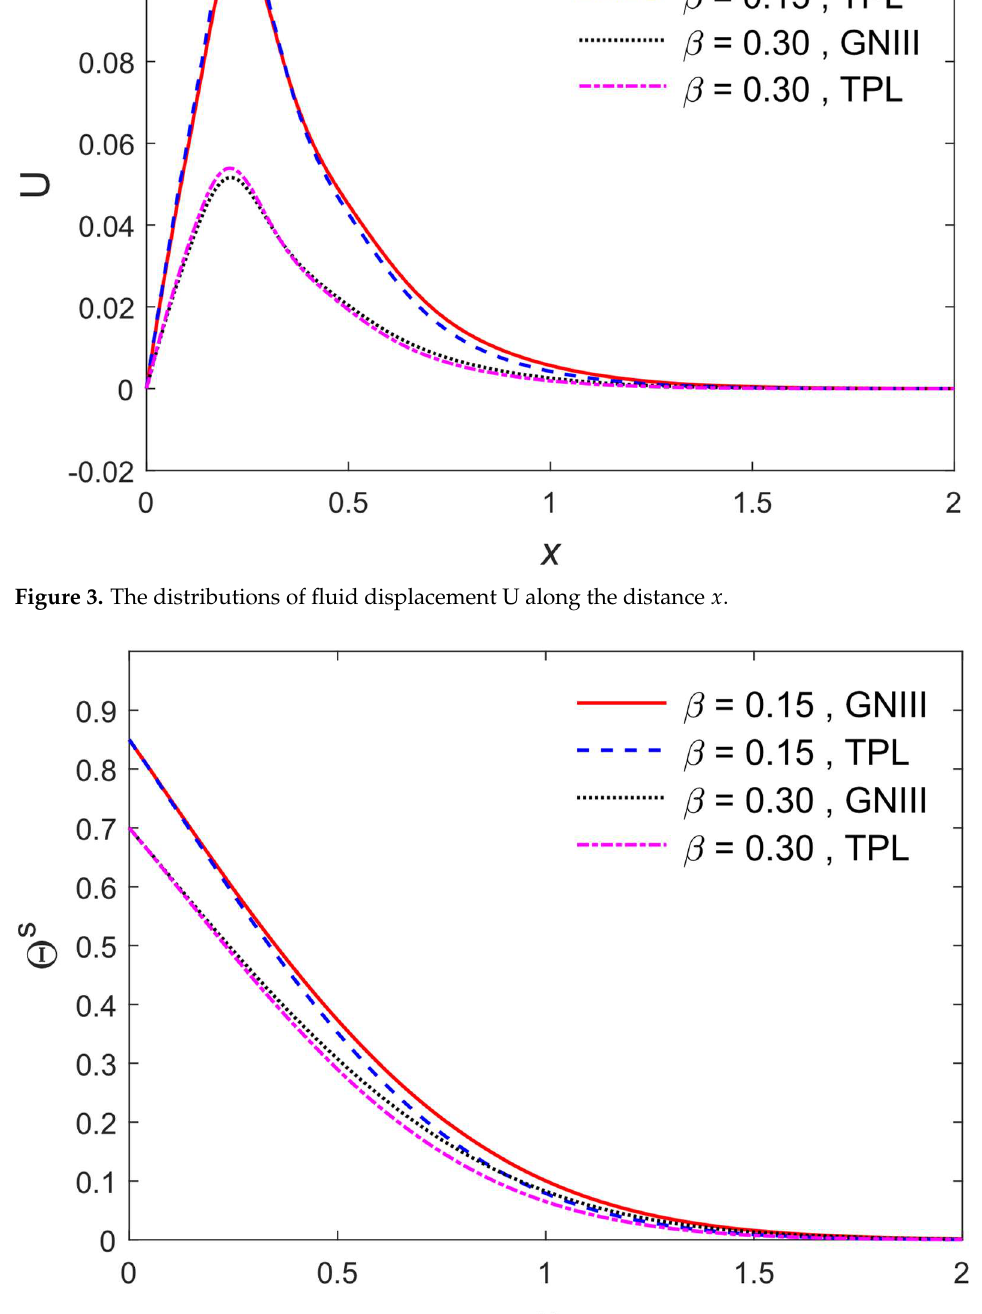
Figure 4. The distributions of solid temperature Θ (cid:2929) along the distance 𝑥 .